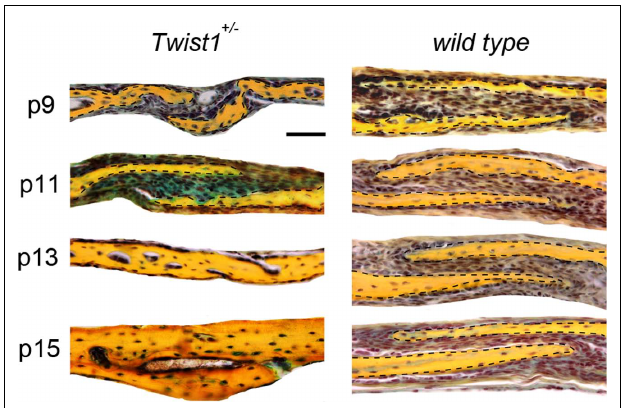
FIGURE 2 |Time course of COR suture closure in Twist1 + / − mice. At day p11 pentachrome staining reveals the presence of cartilage (blue staining) between the bone plates of the COR suture of Twist1 + / − mice, while no cartilage is present in wild-type mice. By day p13, pathological closure of COR suture is observed in Twist1 + / − mice. Dashed lines indicate the bone plates. Scale bar: 50 μ